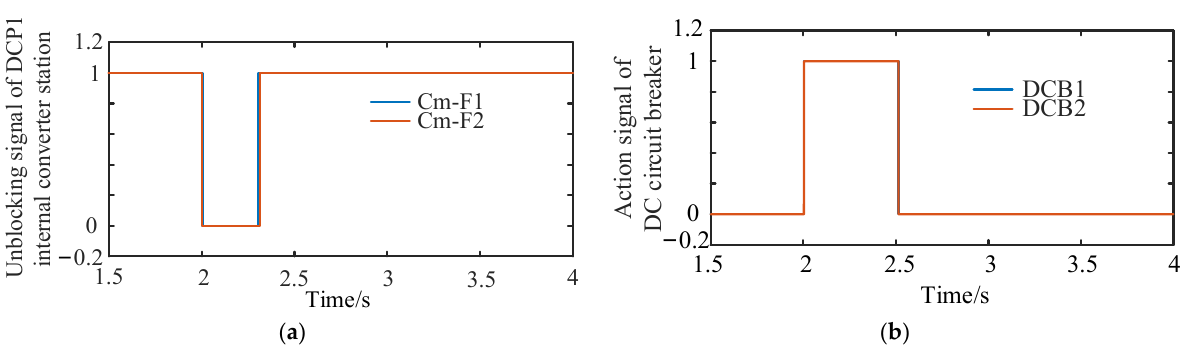
Figure 18. Protection boundary element action signal in DCZ 1 . ( a ) Unblocking signal of converter station in DCZ1; ( b ) DCZ1 protection boundary of DC circuit breaker action signal.